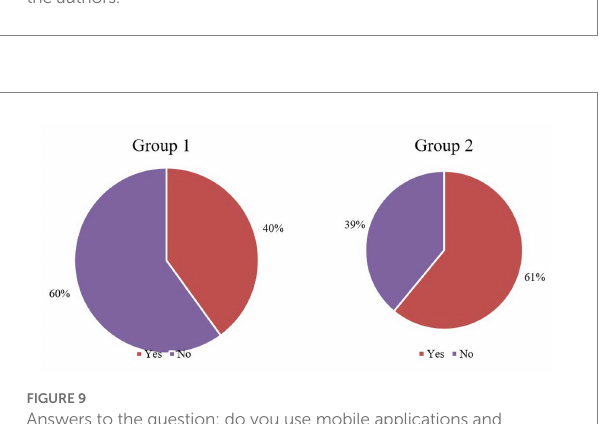
FIGURE 9 Answers to the question: do you use mobile applications